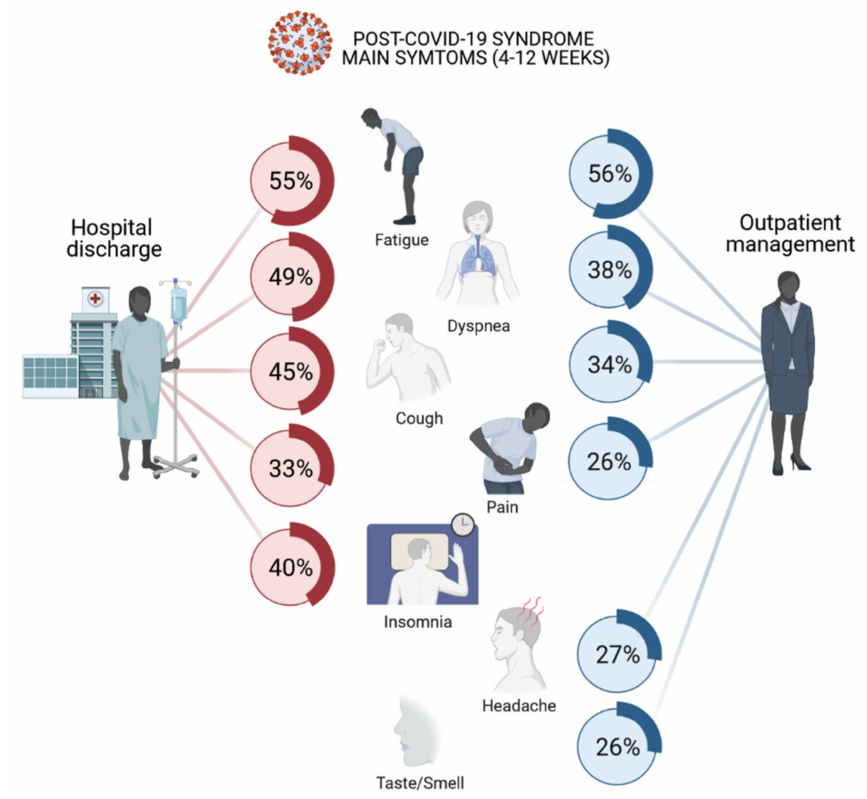
Figure 2. Prevalence of main symptoms in post-COVID-19 syndrome, hospitalized [40–50] or outpatients [51–56], evaluated between 4 and 12 weeks after diagnosis. The mean of the presentation of symptoms appears considering all the studies that